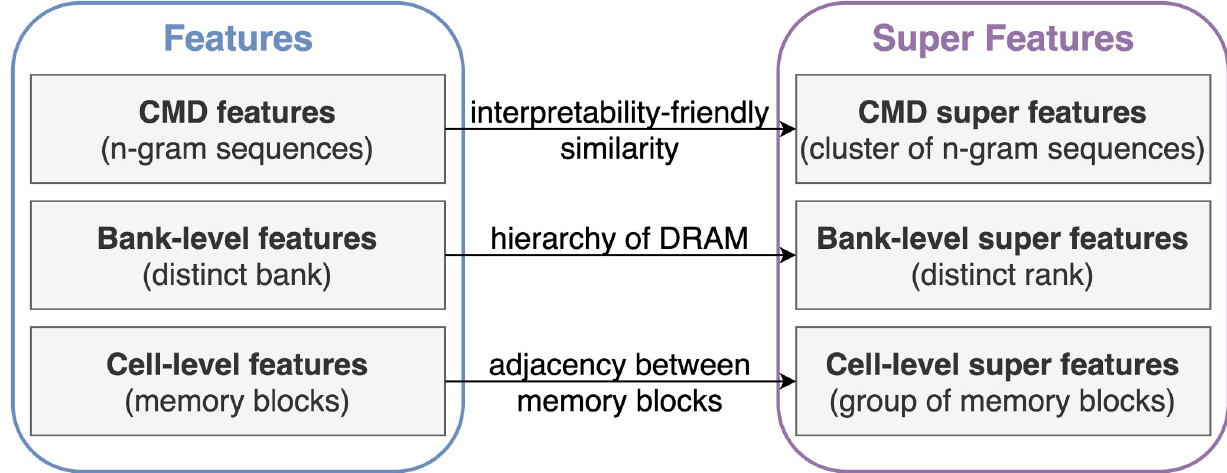
Fig 2. Overall process of generating super features. We define three different types of super features for workload classification. Super features are designed to capture the similarity between the original features, and are commonly applied to every workload subsequence.